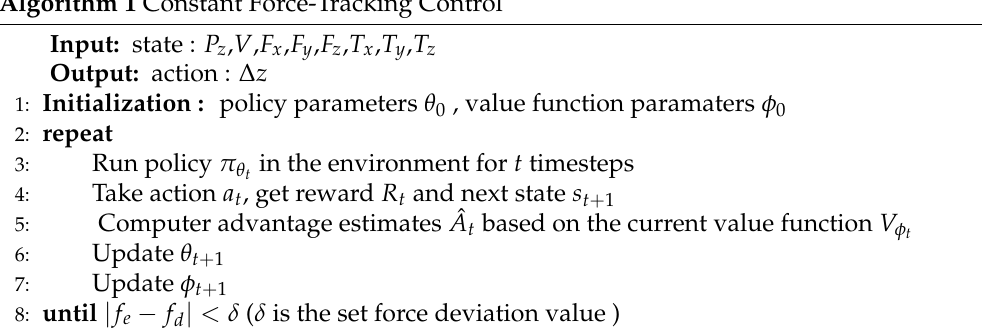
Algorithm 1 Constant Force-Tracking